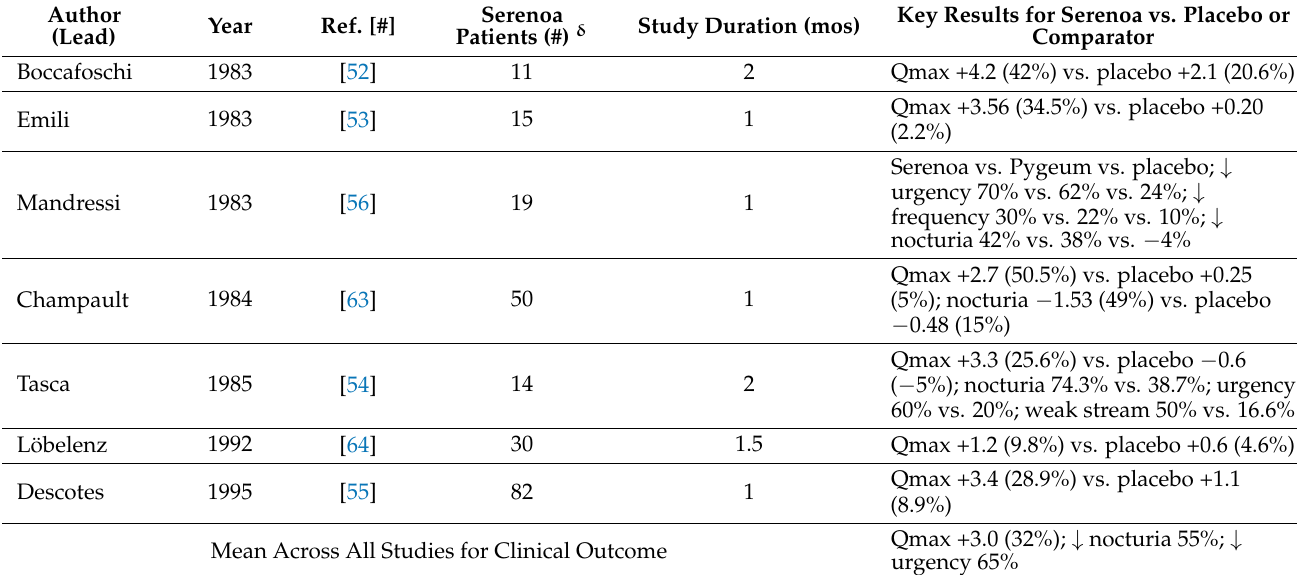
δ The number of patients at study end, or as reported. Löbelenz study did not specify how many patients in LSESr cohort at the end of the study. ↓ , decreased; − , negative change; #, number; +, positive change; mos, months; Qmax, peak urinary flow (mL/s); Ref., reference citation; vs.,